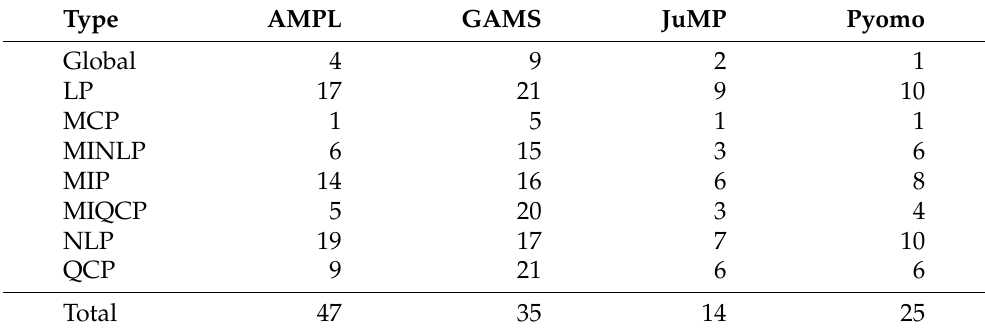
Table 2. The number of solvers supported by AMLs grouped by the problem type.